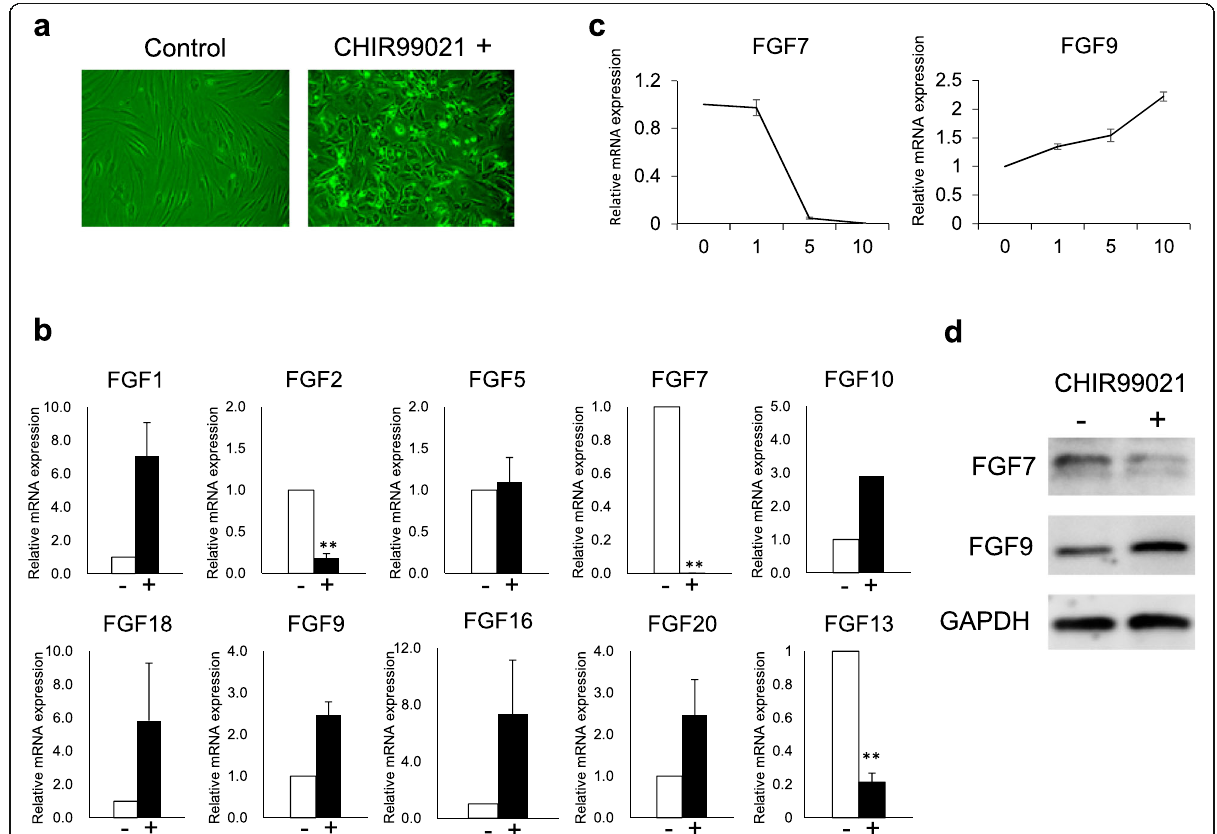
Fig. 2 Effect of WNT activation on morphology and gene expression of FGFs in human-scalp derived-fibroblasts. a Morphological alteration of human scalp-derived fibroblasts (sFBs) after 1 week cultivation with a WNT agonist. b Influence of WNT activation on gene expression of representative FGFs in sFBs. * p < 0.05. ** p < 0.01. The data were obtained by three respective experiments. c Dose-dependent changes in FGF7/9 expression after 1 week culture with different concentration of CHIR99021. The data were obtained by two respective experiments. d Western blotting analyses of FGF7/9 expression in sFBs after 1 week culture with